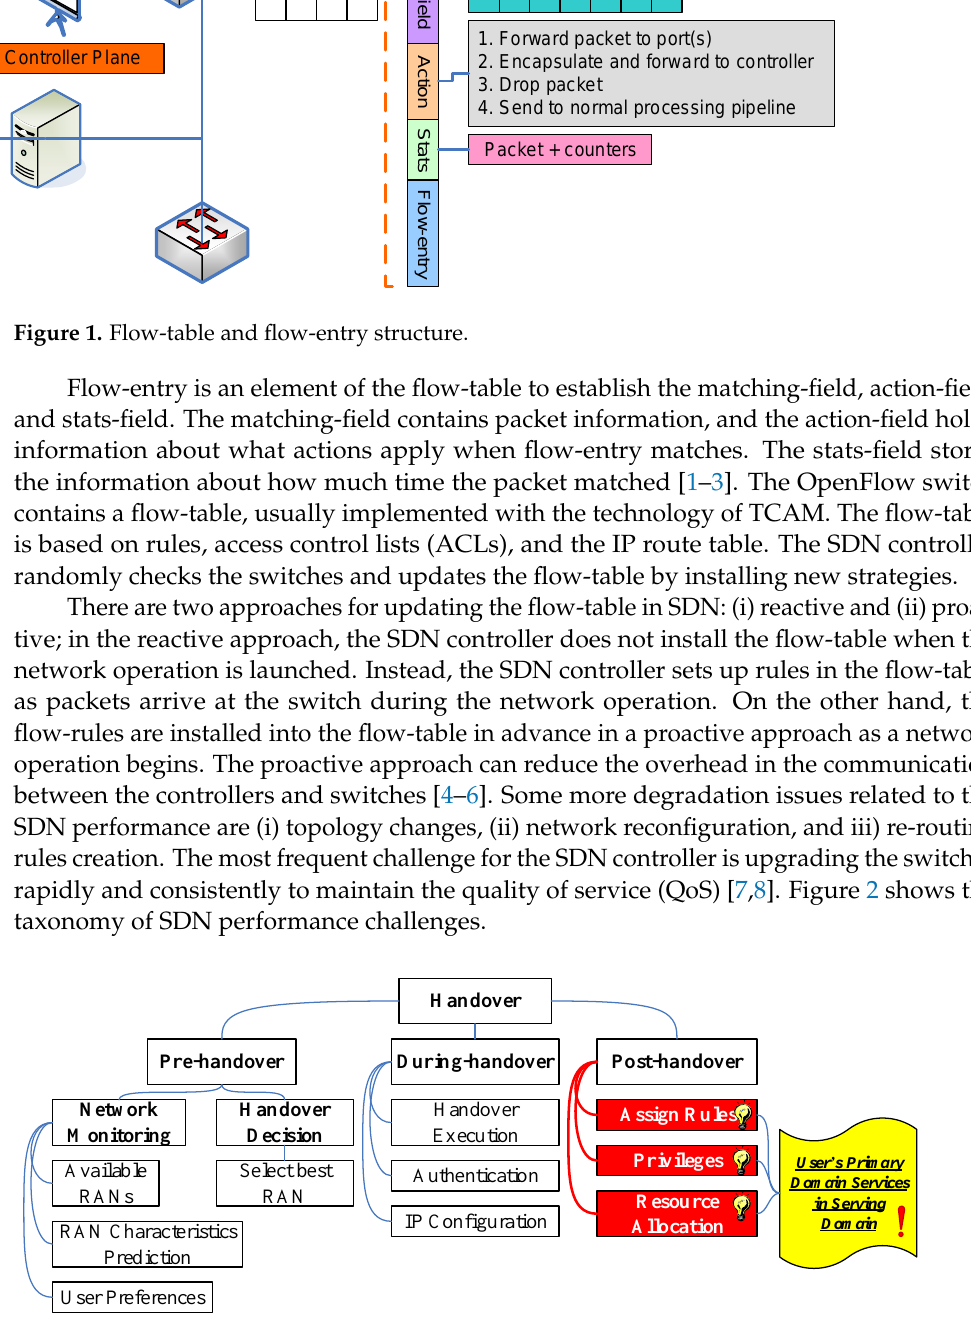
Figure 2. Handover challenges . Figure 2. Handover